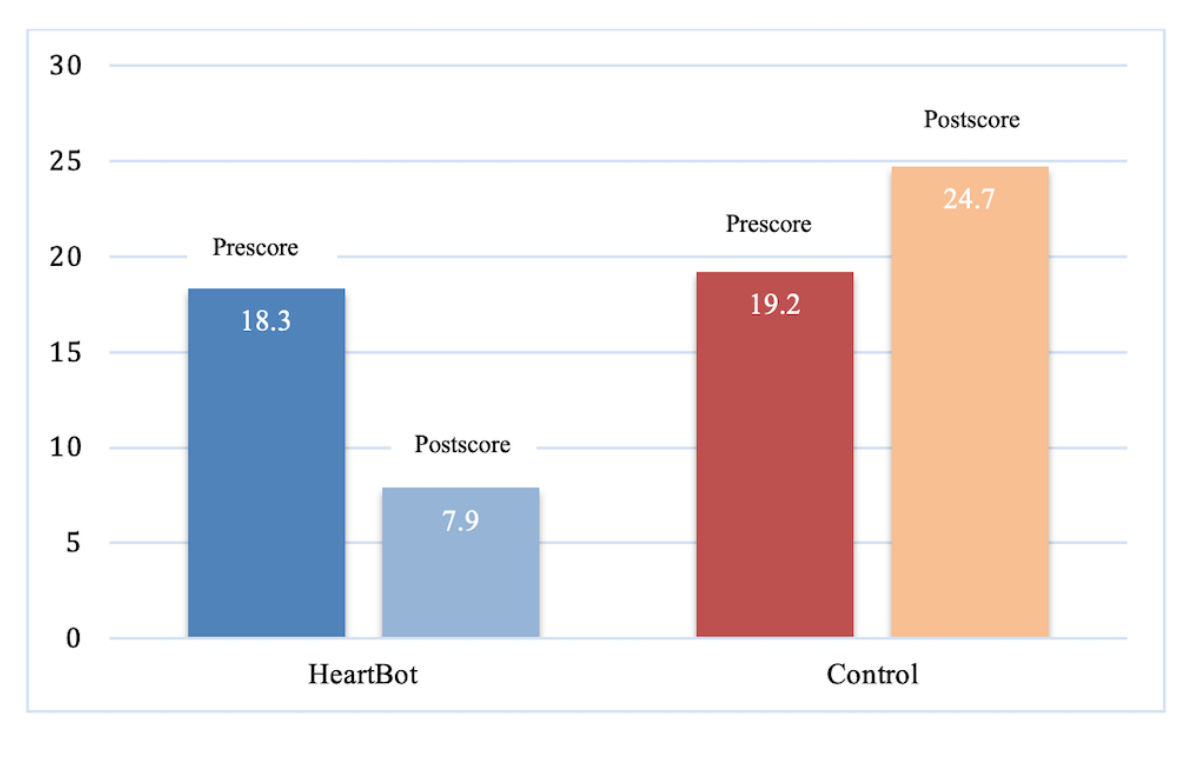
One-way ANOVA examined the difference between the